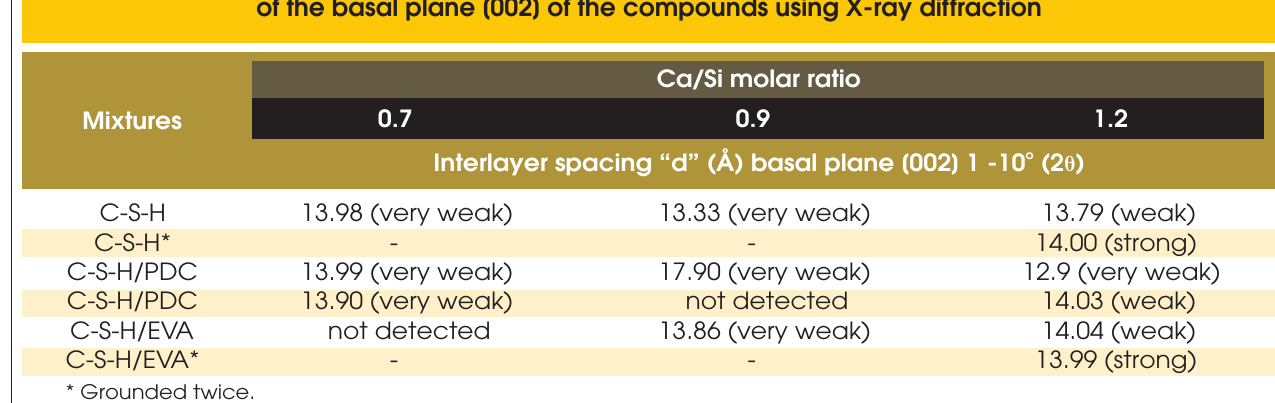
of the basal plane [002] of the compounds using X-ray diffraction